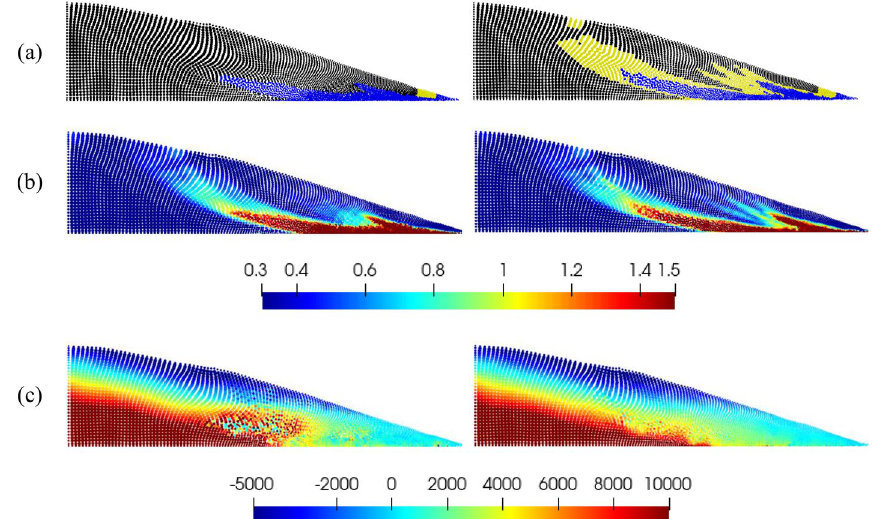
Fig. 24 Coupled L–SL simulation results t = 1.35 s obtained with sudden transition (left) and gradual transition (right): a L‑RK (black), SL‑RK (blue), and transition (yellow) zones; b equivalent plastic strain; c pore wave pressure